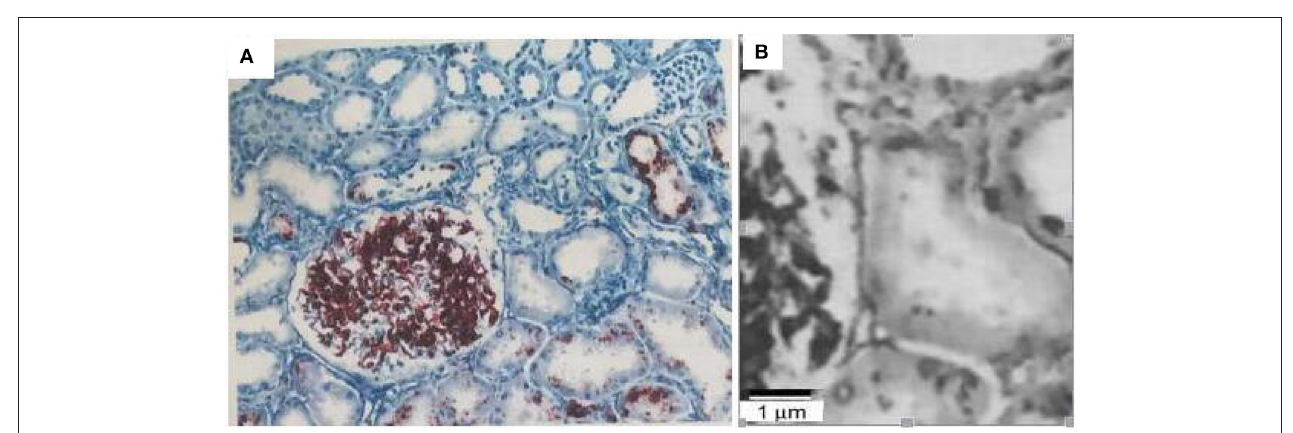
FIGURE 2 | Renal biopsy findings of the patients with focal segmental glomerulosclerosis, mild tubular atrophy, and renal interstitial fibrosis. Scale bar is 40 um (A) and 1 um (B) .